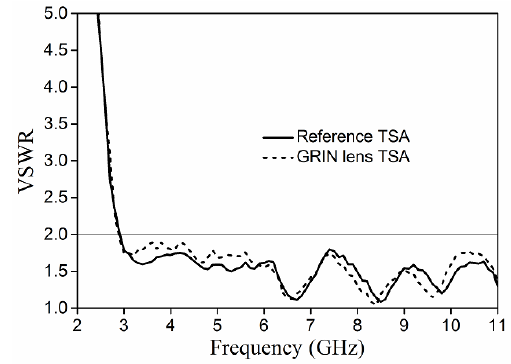
Figure 10: VSWR of the reference and GRIN